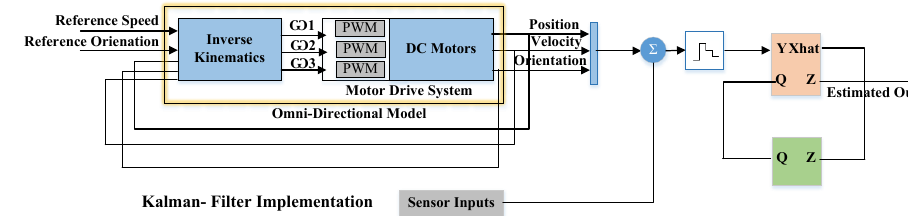
Figure 6. Architecture of robot kinematics and integration of Kalman filter in